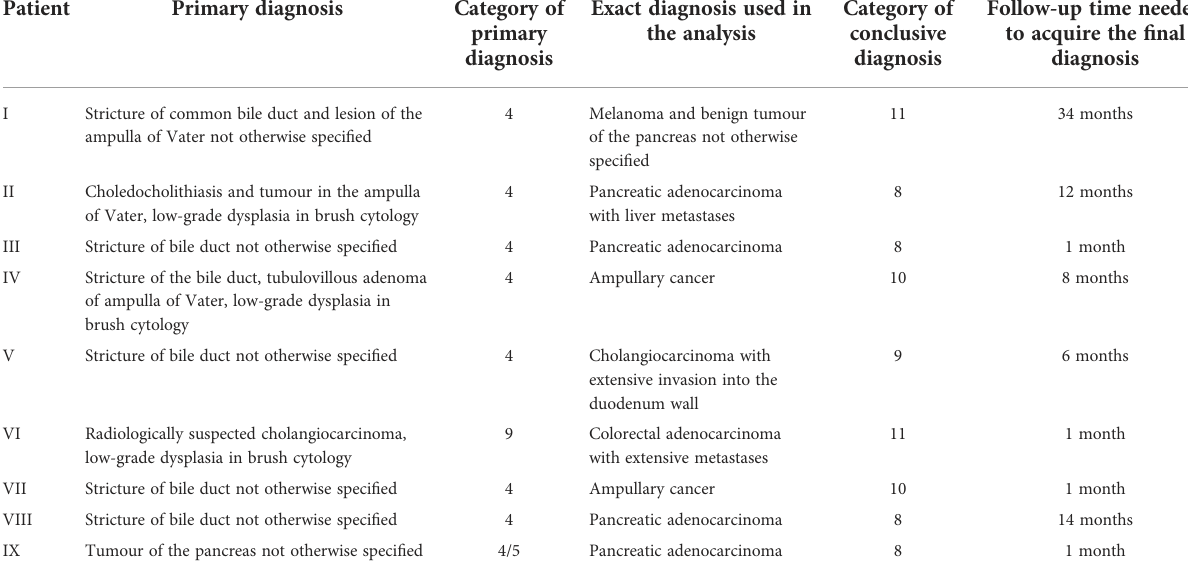
TABLE 1 Pathology categorizations changed in nine patients during the